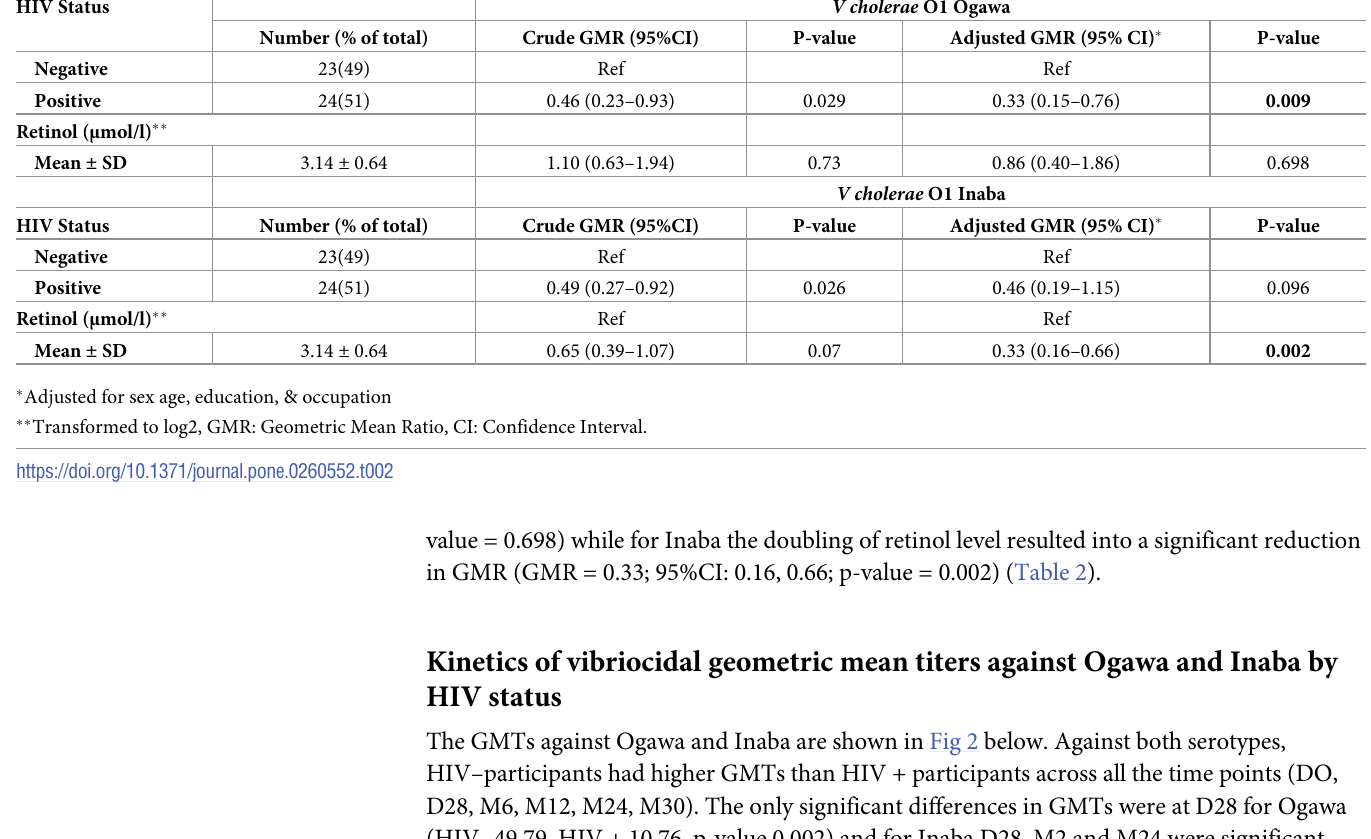
Table 2. Effects of HIV status and retinol on the immune response to OCV.